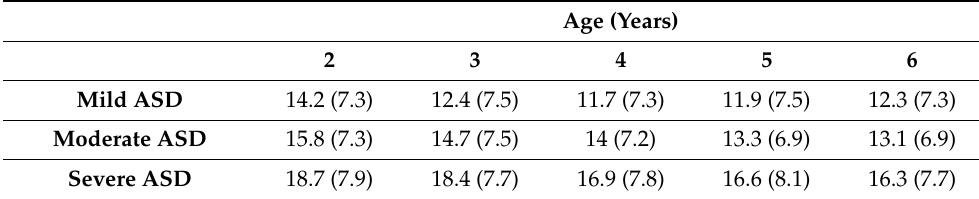
Table 4. Averaged Sociability (assessed by ATEC subscale 2) score for the mild, moderate, and severe ASD groups. A lower score indicates symptom improvement. The data are presented as the mean (SD). Age